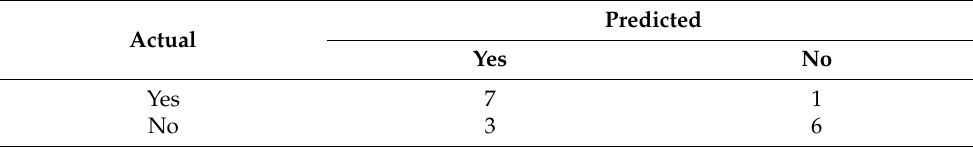
Table 2. Decision tree’s confusion matrix.